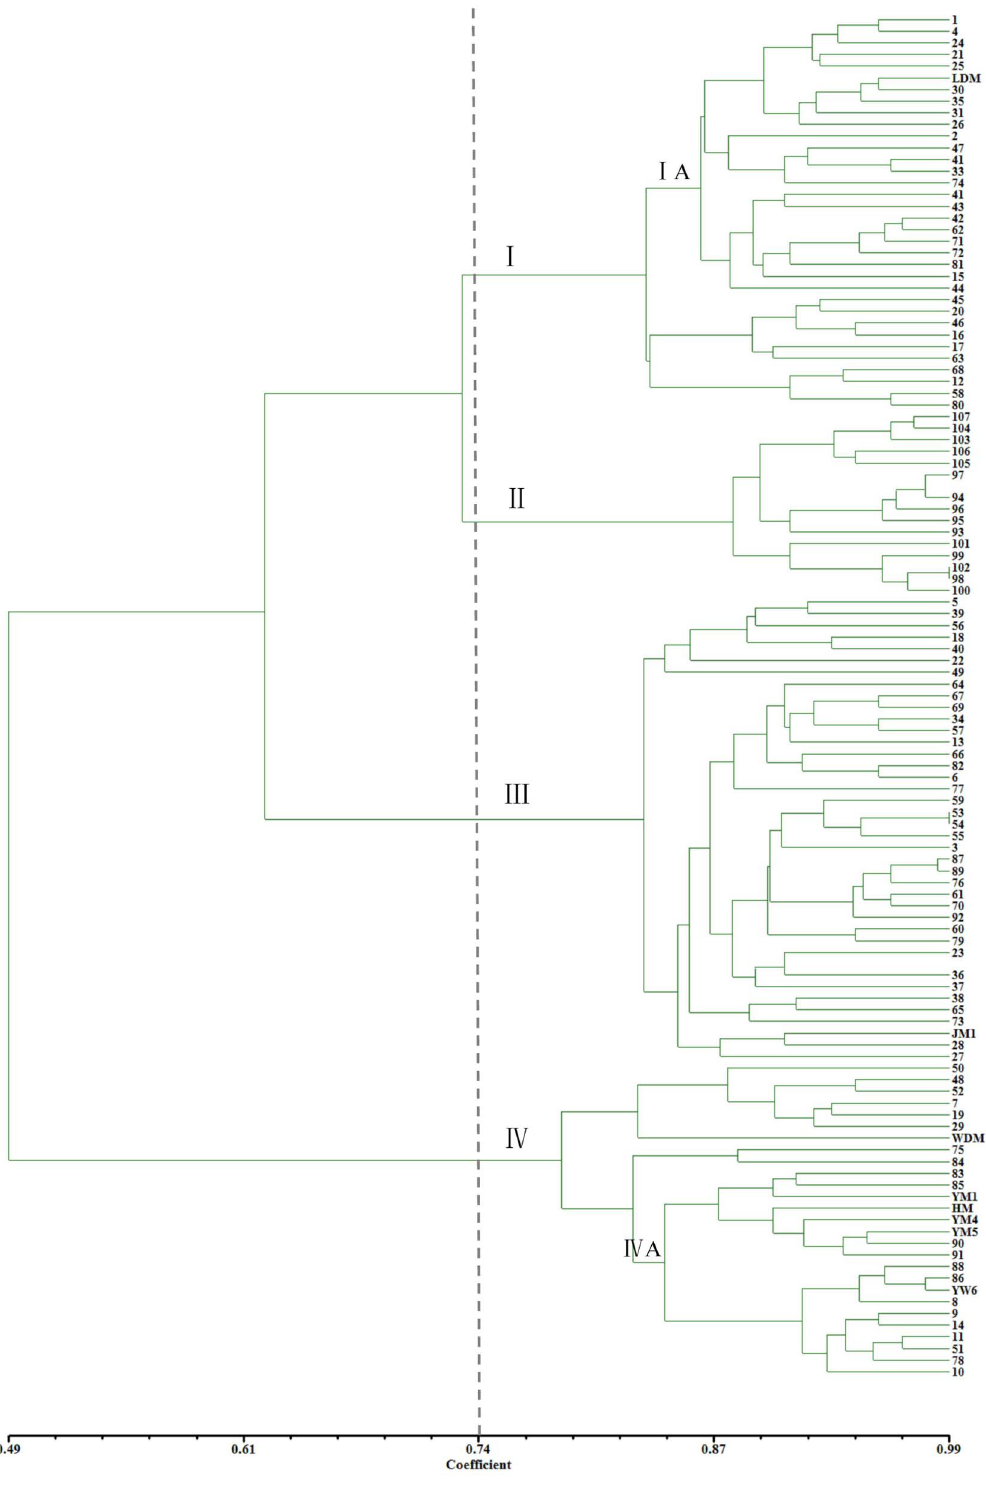
Figure 2. Dendrogram derived using UPGMA cluster analysis based on the SSR genetic similarity coefficient for 115 cannabis varieties. doi:10.1371/journal.pone.0110638.g002 among 24 cannabis varieties. Of these, 108 (92.31%) SSRs successfully yielded amplicons. Given that the SSRs were randomly selected, the amplification efficiency may be considered